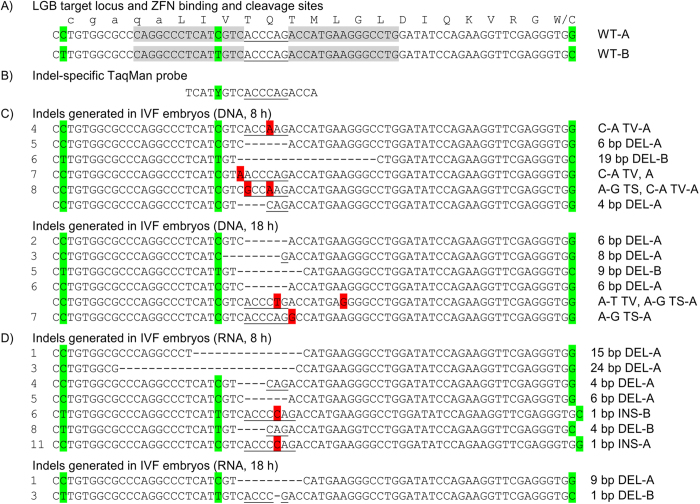
LGB target locus and target-specific indels generated by ZFN injection into one cell embryos.(A) Shown is the DNA sequence for the relevant region of the LGB target locus for the two main wild type LGB variants A (WT-A) and B (WT-B). The encoded amino acids of BLG are given in single letter code above the DNA sequence with lower case indicating amino acids of the signal peptide and upper case amino acids of the mature protein. Nucleotides highlighted in green depict polymorphic sites differing in WT-A and WT-B. The ZFN binding sites are indicated by grey boxes and the ZFN cleavage site is underlined. (B) Sequence of the TaqMan probe used for the mutation specific PCR assay and its position relative to the LGB locus. At the polymorphic site, the probe contains a pyrimidine (either C or T) shown as Y. (C) Sequence of mutated alleles generated by injection of DNA-encoded ZFNs into individual IVF embryos, numbered on the left. The mutations are detailed on the right with size in bp, deletion (DEL), insertion (INS), transversions (TV) and transitions (TS) and in which LGB variant (A or B) the mutation was introduced. Sequence changes of DELs are indicated as dash and additional nucleotides and other point mutations are highlighted in red. D) Mutations generated by injection of RNA-encoded ZFNs into individual IVF embryos.